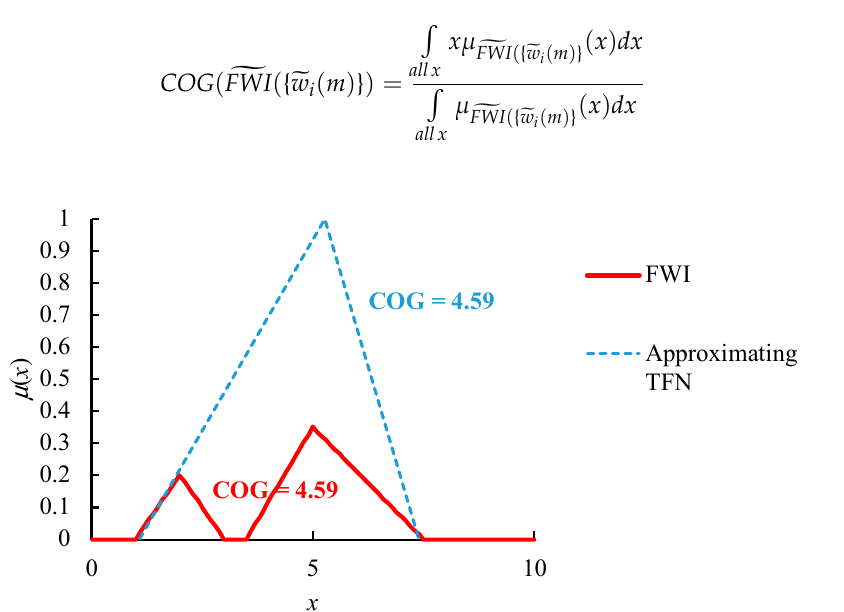
Figure 3. Approximating the fuzzy weighted intersection (FWI) result with a triangular fuzzy number (TFN).